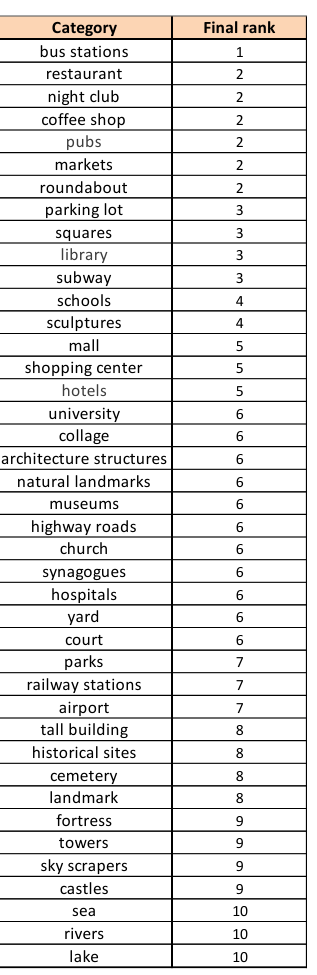
Table 3. Final score of common landmark list 3.4.2 Find which entries are placed in a radius of Y from the search points: Using the Wikipedia API one can retrieve the nearby wiki information, and a list of all pages and their location (coordinates). For example: https://en.wikipedia.org/w/api.php?action=query&list=geosearc